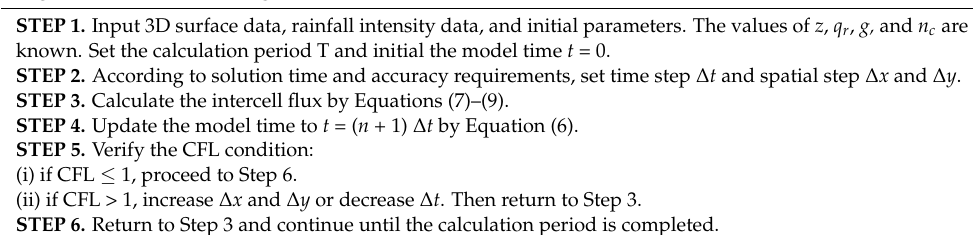
Algorithm 2. Numerical Algorithm for 2DDA-SWE